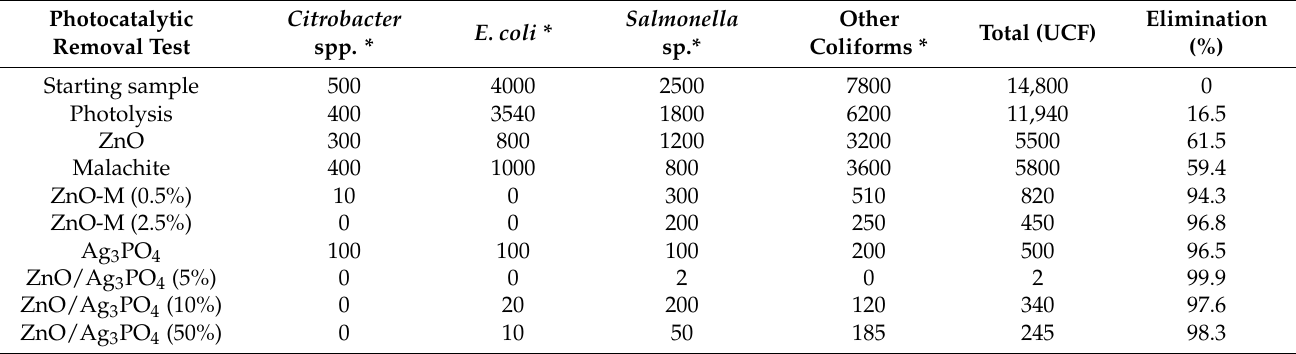
Table 2. Enteropathogenic bacteria removed from a river water sample highly polluted with municipal wastewater.